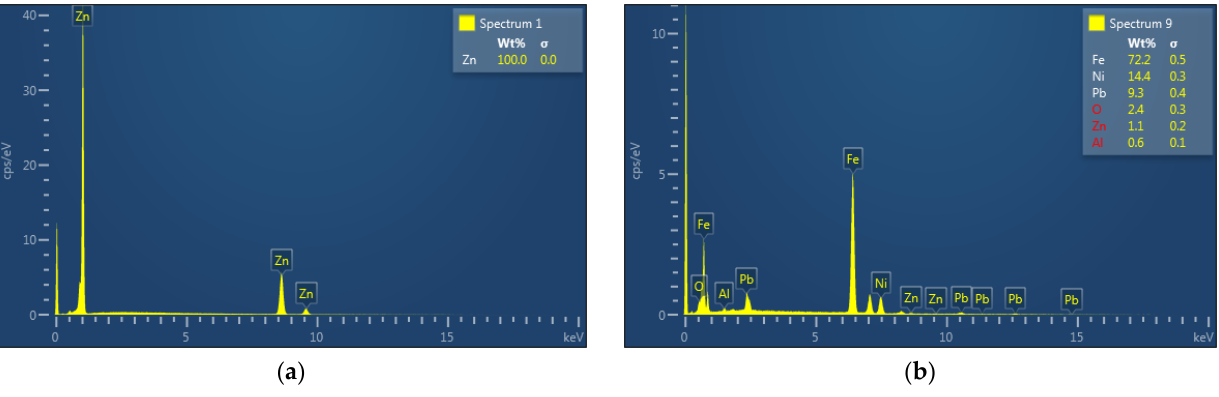
Figure 14. EDX of ( a ) zinc drop product and ( b ) the residue after evaporation by 800